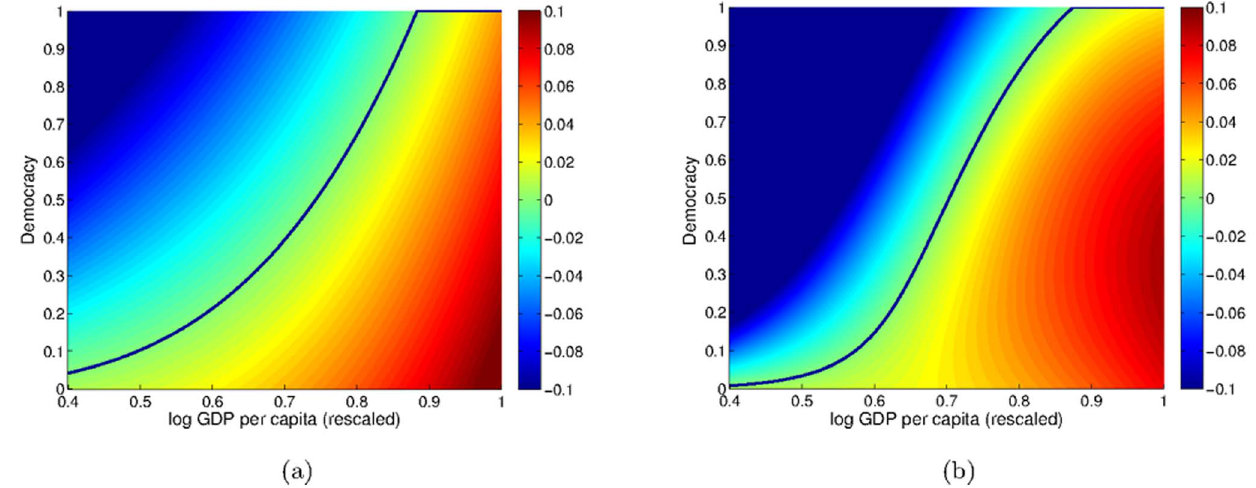
Figure 3. A heatmap of change in democracy models. For (a) the two term model given by equation 7 (b) the five term model given by equation 8. The colour scale gives the rate of change of democracy (i.e. dD